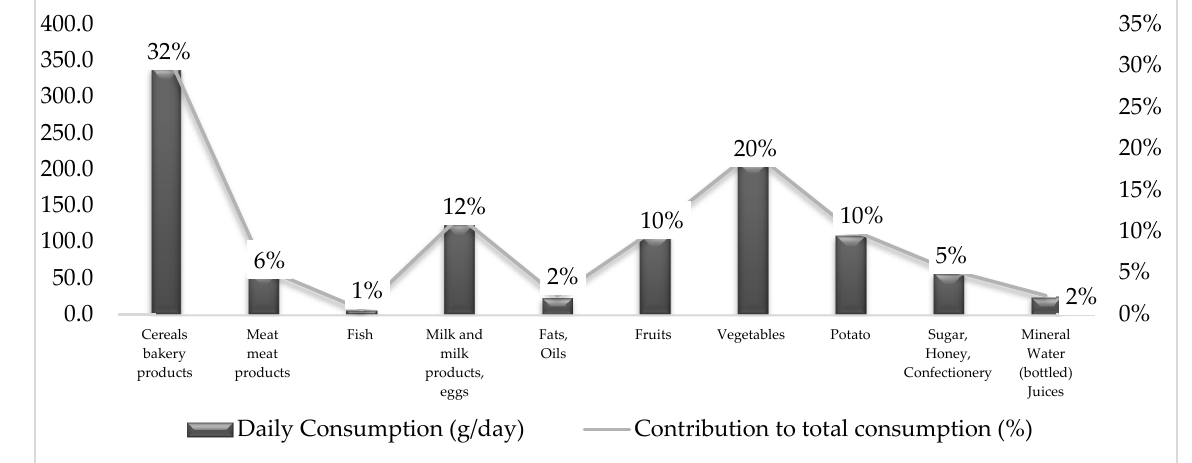
Figure 1. Daily consumption of main food groups per capita (g/day) and structure of consumed food in the Integrated Living Conditions Surveys. Armenia 2019.